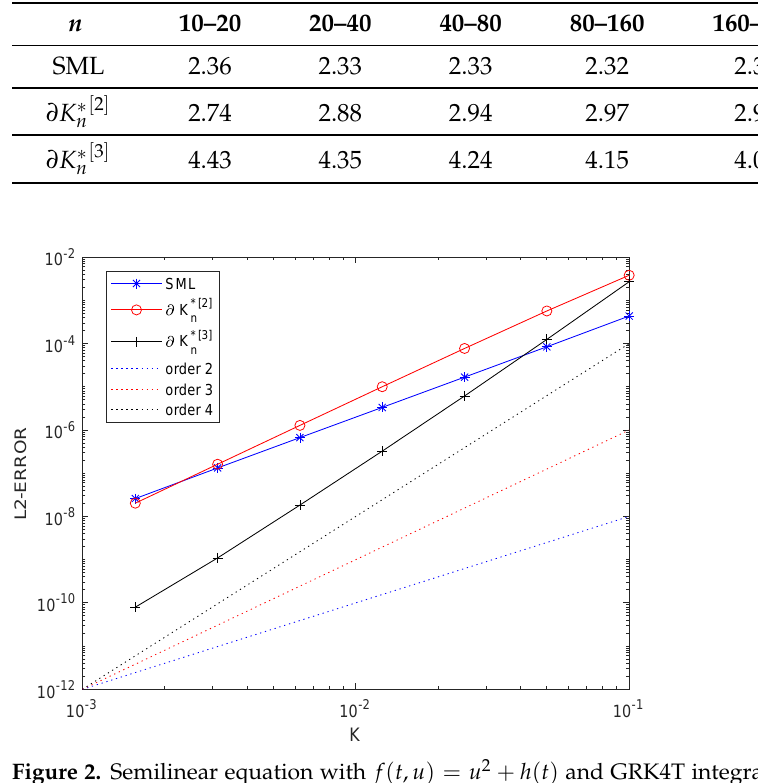
Table 2. Orders for global error, GRK4T and f ( t , u ) = u 2 + h ( t ) , with Robin boundary condition. SML stands for ‘standard method of lines’ and ∂ K ∗ n [ 2 ] , ∂ K ∗ n [ 3 ] for the different variations of the technique suggested in this paper.